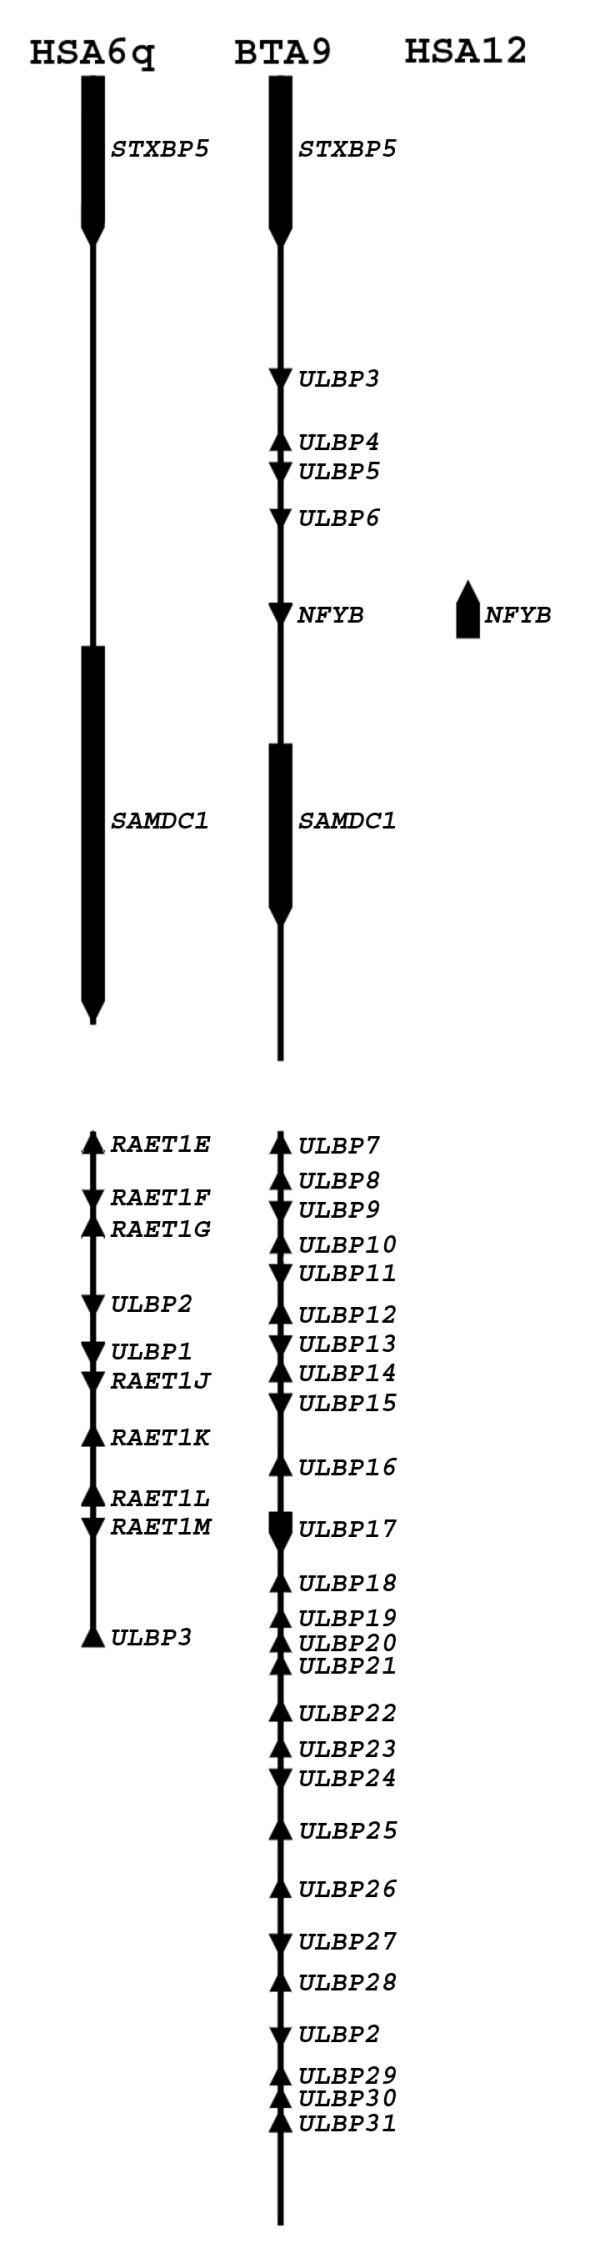
Scaled comparative map showing homologous ULBP-containing chromosome regions in cattle and human. Arrows indicate gene orientation. The BTA9 upper and lower seqments represent the major and minor ULBP clusters, respectively. Cattle BAC contig sizes and gene positions are found in Tables 1-3. The upper and lower chromosomal segments from HSA6q depict sequence positions 147,566–148,013 Kbp and 150,302–150,482 Kbp [NCBI Build 35], respectively. The HSA12 chromosomal segment represents positions 103,013–103,034 Kbp [NCBI Build 35].